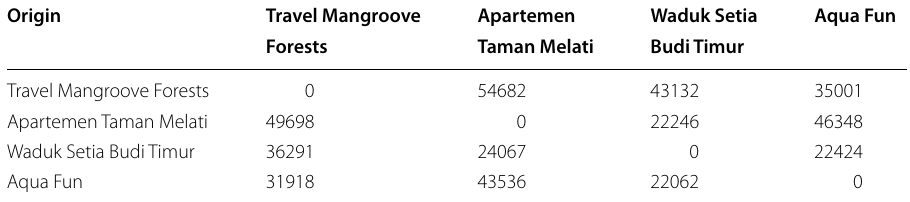
Table 2 Sample of Distance Matrix (in